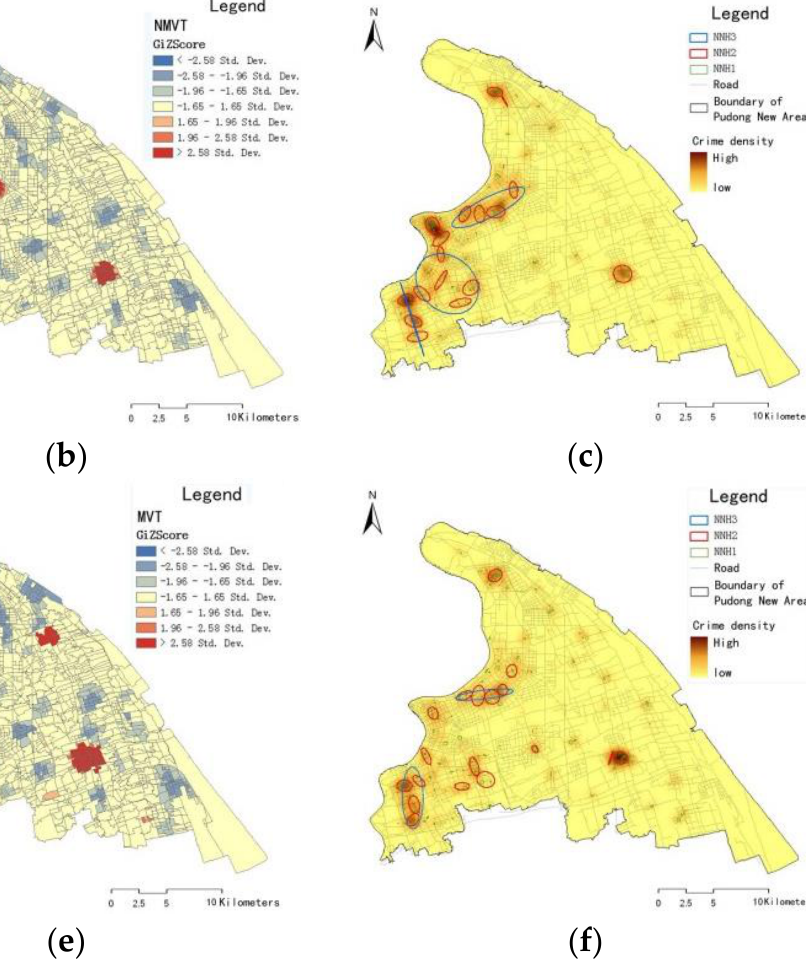
Figure 2. Non-motor/motor vehicle thefts: standard deviational ellipse and mean centers ( a , d ), local spatial auto-correlations ( b , e ), and hierarchical nearest-neighbor clusters ( c , f ).